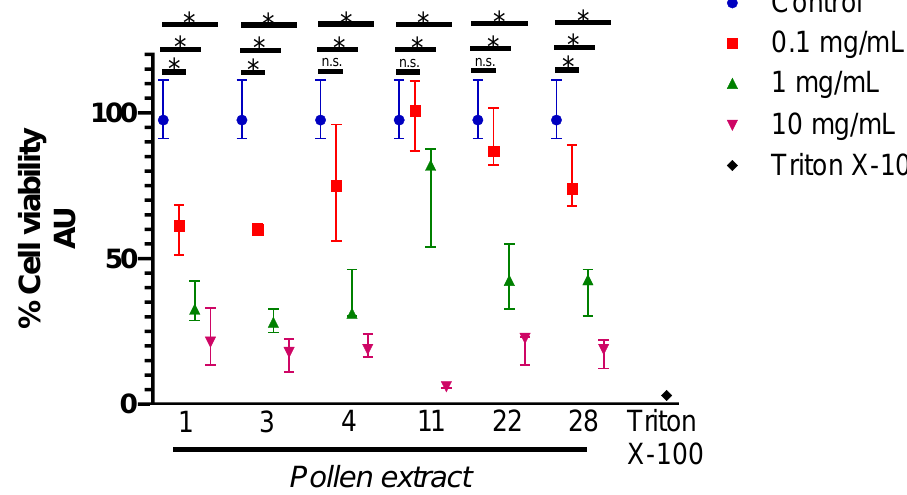
Figure 1. Maximum concentration of pollen extracts. Cell viability evaluated by Alamar blue of Hepa1-6 cells treated with ethanol extracts of pollen 1, 3, 4, 11, 22, and 28 at different concentration (0.1, 1, 10 mg/mL). Negative control, cells treated with TritonX-100 at 1% for 10 min. Arbitrary Units (AU). Cell viability expressed as a percentage of viable cells relative to the control cells (untreated cells). Data are shown as median ± first quartile and third quartile ( n = 3). Mann-Whitney statistical test was performed between the control group and different pollen concentrations. The asterisks (*) represent statistically significant differences ( p < 0.05). n.s.: not significant.